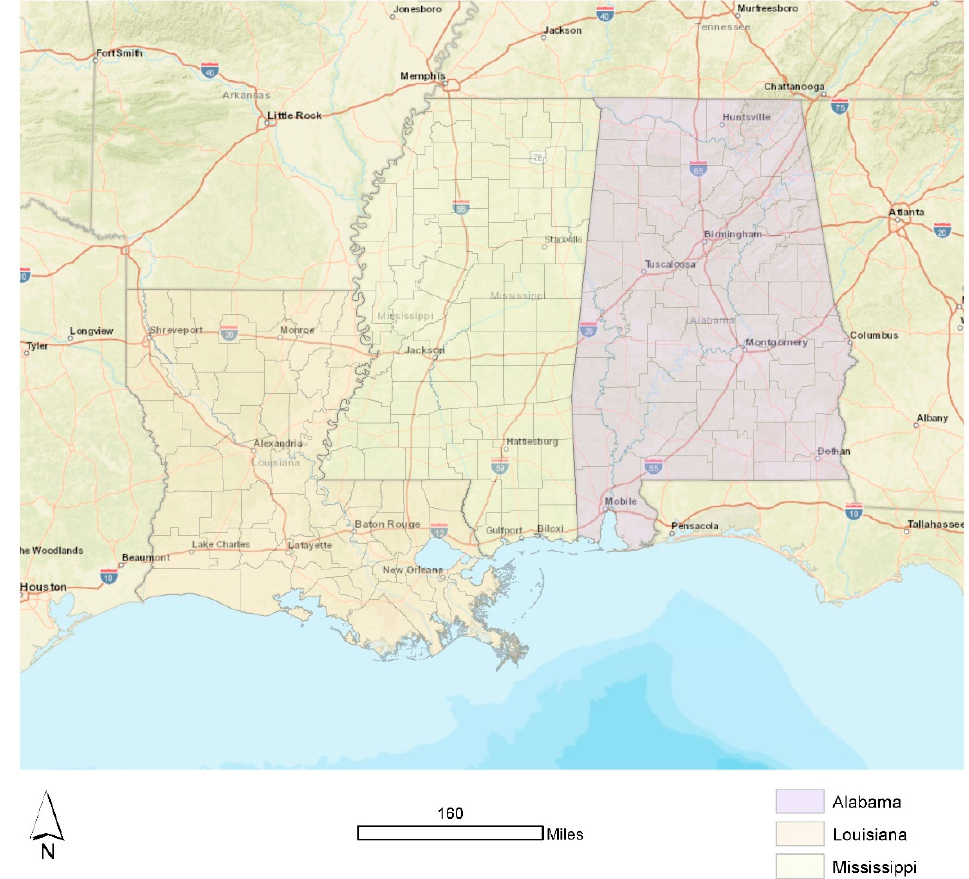
Figure 1. Study area: Louisiana, Mississippi, and Alabama.